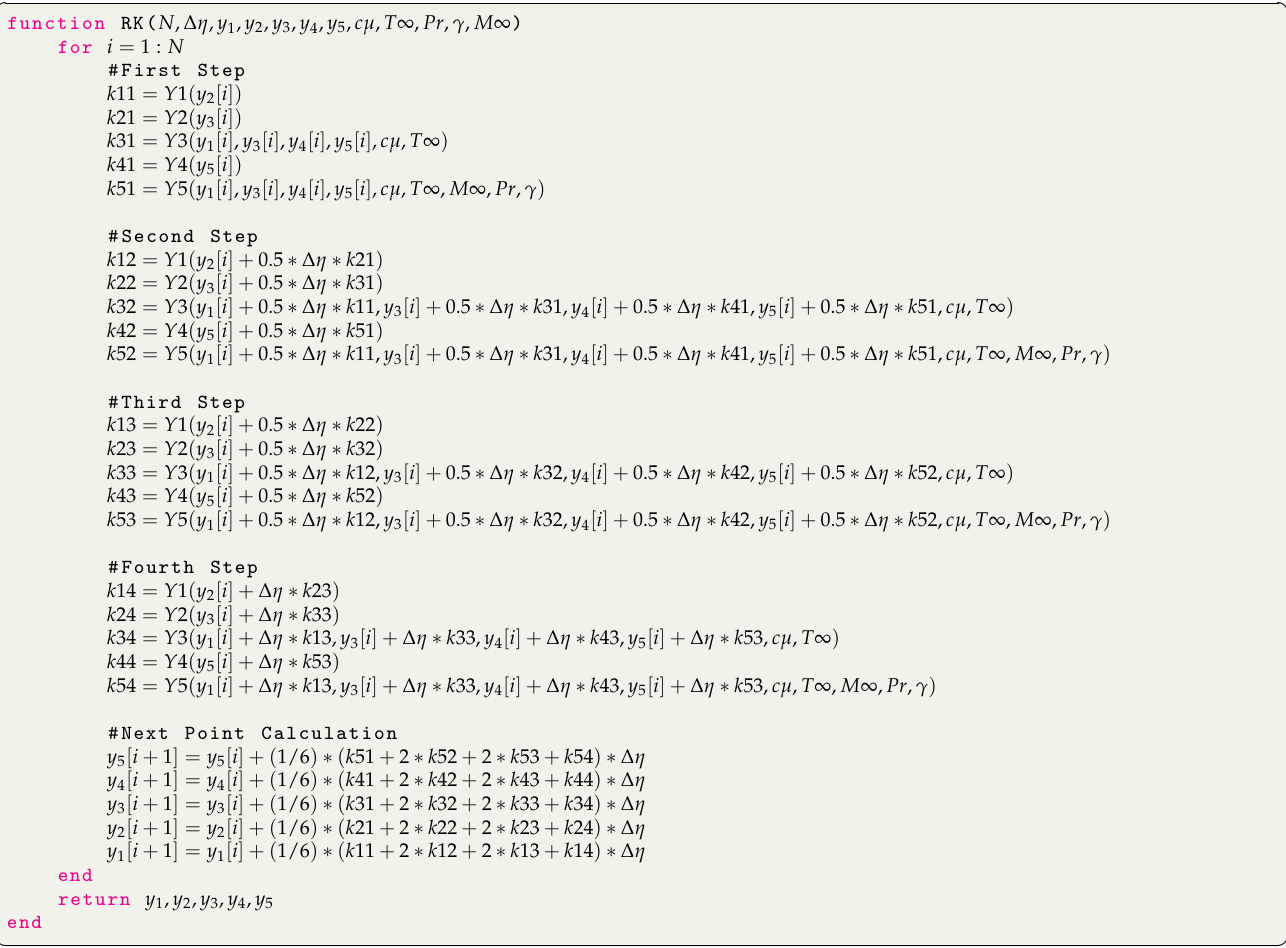
function value in the next node value.